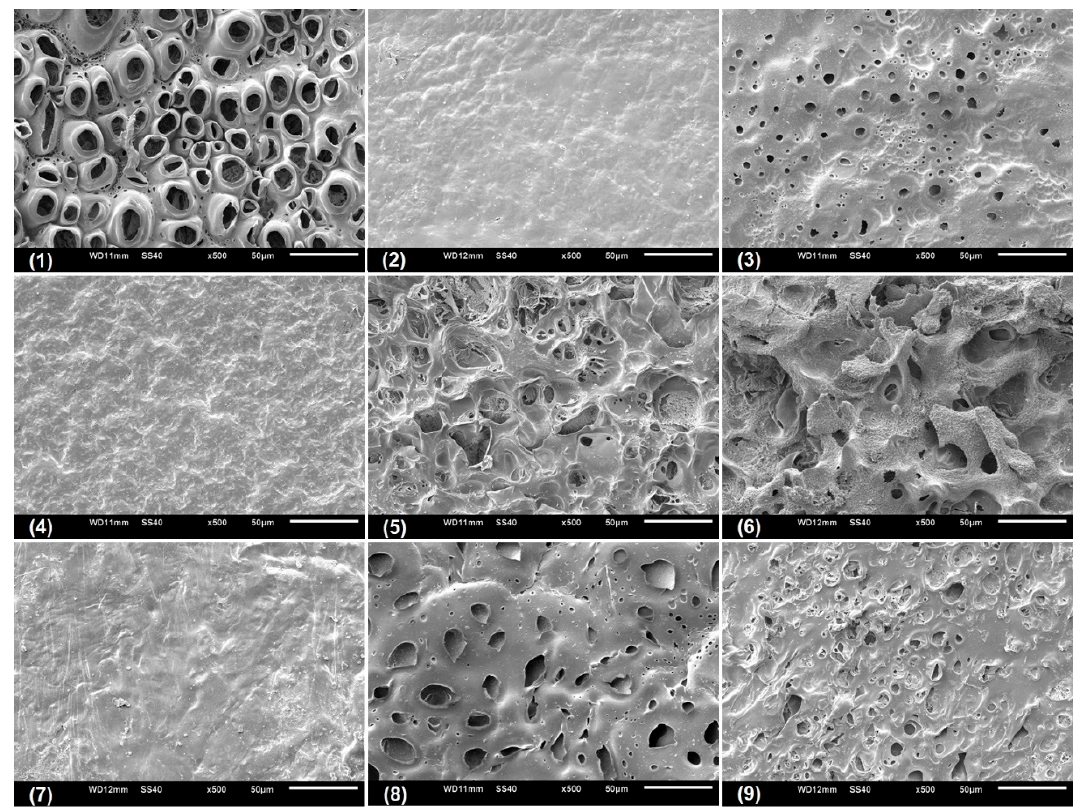
Figure 5. Scanning electron micrographs of CGP/PVA films swollen in acetate buffer (pH 4.5).